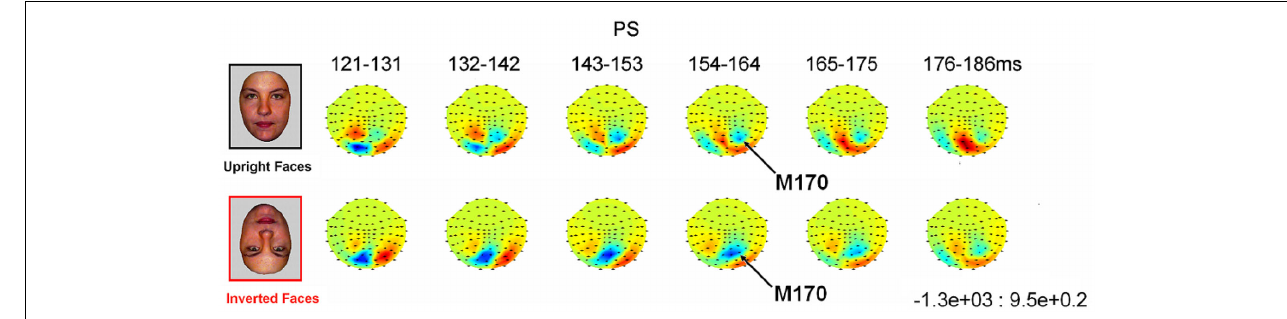
between sensors, indicated by black dots, after their spherical projection onto a 2D surface). Red and blue indicate outward and inward radial direction of magnetic flux through single flux coils within the helmet (in units of